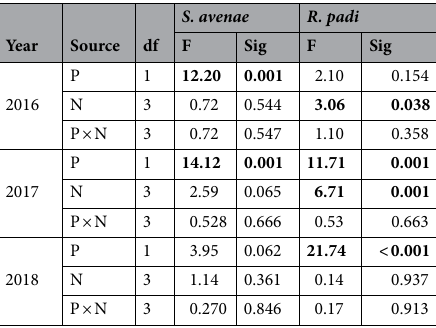
Table 1. Results of split-plot ANOVA for densities of cereal aphids (individuals per 100 tillers), with wheat phase (P) and nitrogen input (N). Significant influence (P < 0.05) is indicated by the boldface.